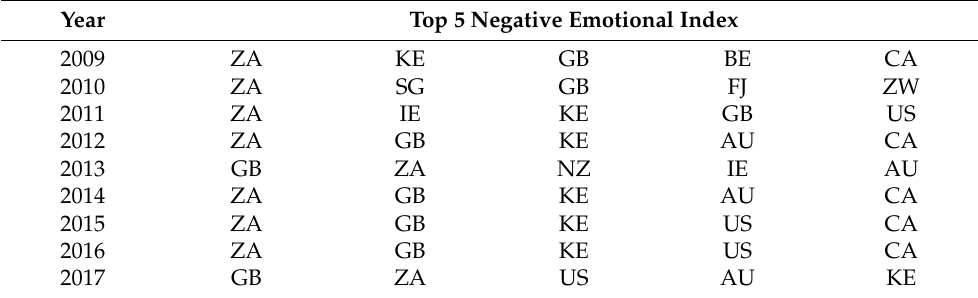
Table 5. The rank of countries owning negative emotional index (top